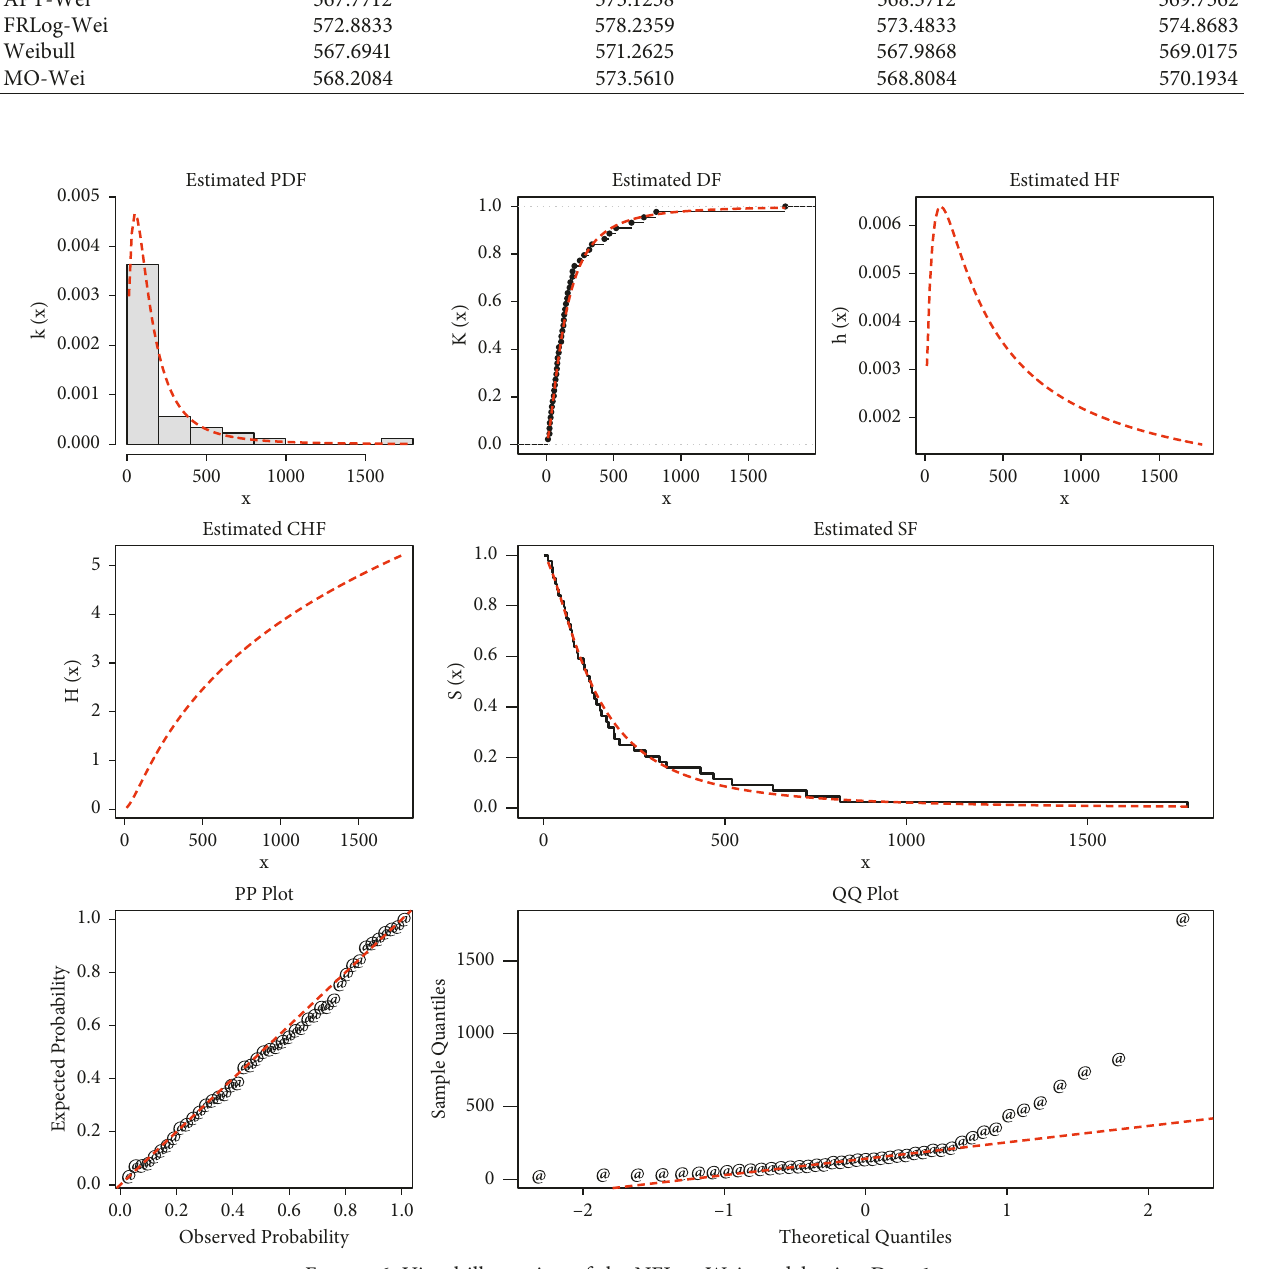
Figure 6: Visual illustration of the NFLog-Wei model using Data